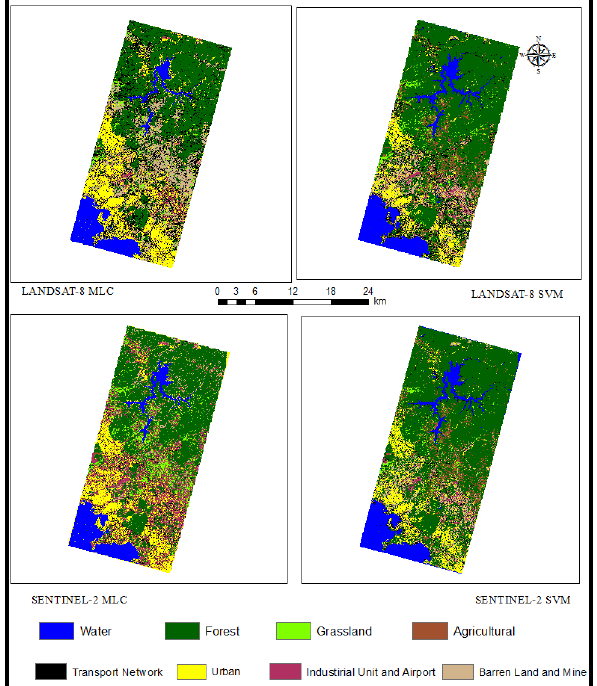
Figure 4. Land Classification using MLC and